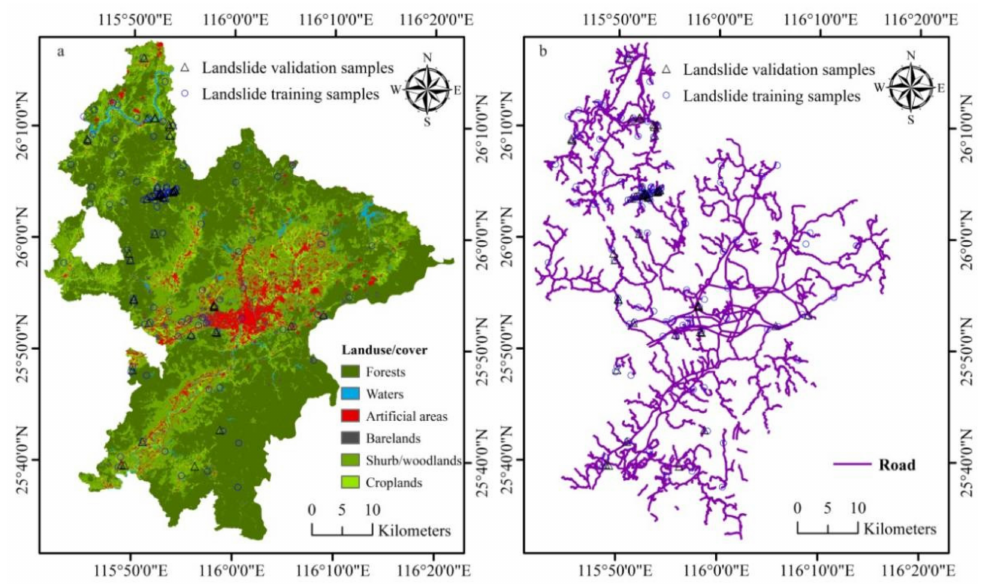
Figure 6. Geo-environmental factors 4: ( a ) landuse/cover and ( b )